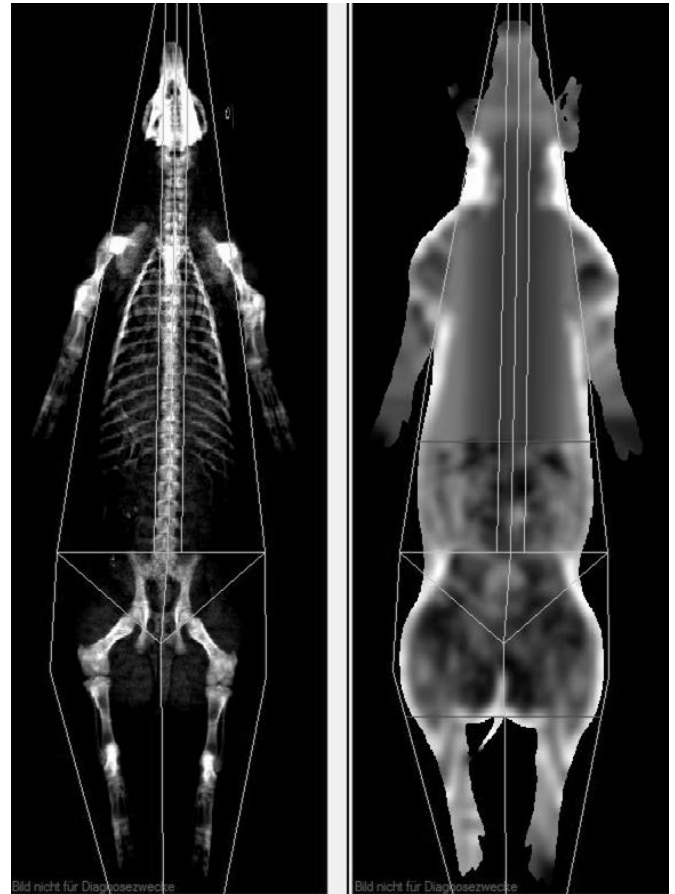
Figure 4. DXA evaluation with enCore software. The uppermost horizontal line (soft tissue image on the right side) defines the level of the origin of the last rib, and the next horizontal line on the top of the iliac crest represents the end of the examined region of VAT.